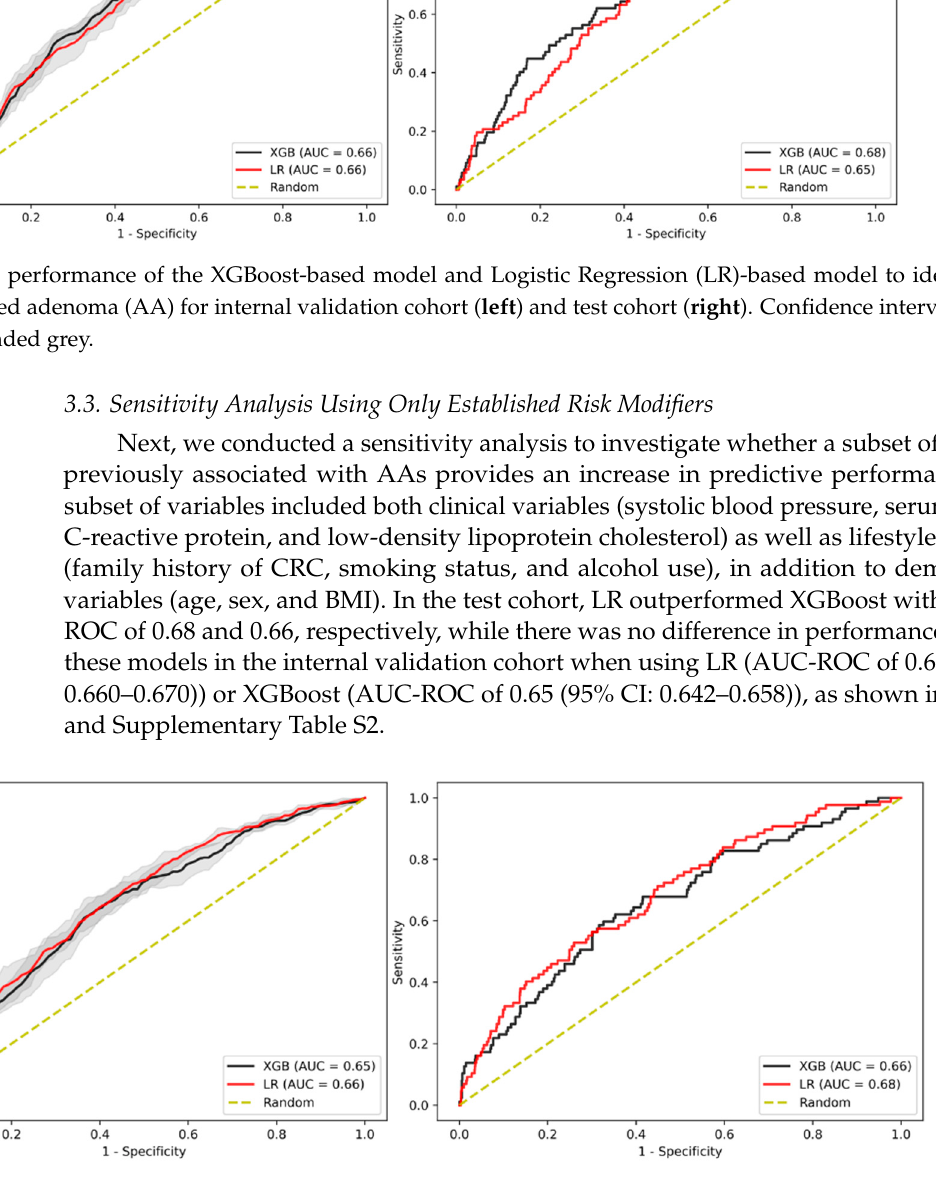
Figure 2. AUC-ROC performance of the XGBoost-based model and LR-based model to identify patients with AA when selecting only variables with a suspected pathophysiological influence of AA risk for the internal validation cohort. Internal validation cohort ( left ) and test cohort ( right ). Confidence intervals of 95% are shown in shaded grey.